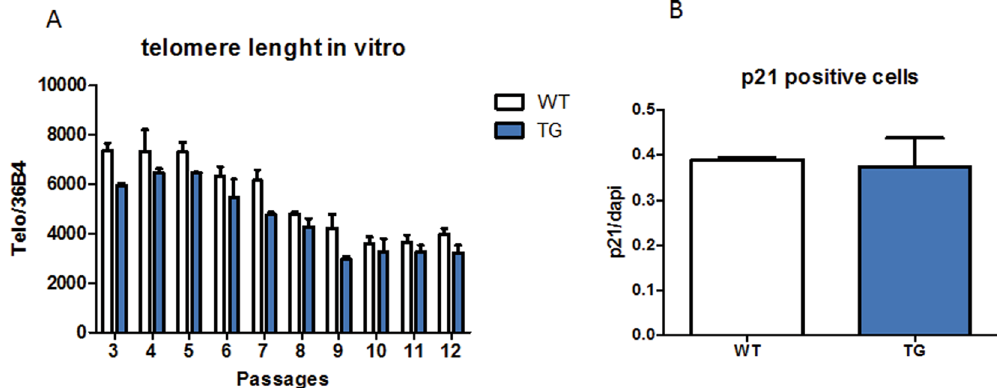
Figure 3. Calpastatin overexpression in tubular cells in vitro does not protect against aging. Prominin 1 positive proximal tubular cells have been isolated by flow cytometry and cultured during 5 months. After 12 passages, telomere lenght decreased similarly in cells from WT and CalpTG (TG) mice ( A , n = 3). In addition, after 6 passages, a similar proportion of WT and CalpTG cells expressed p21, a classical marker of senescence ( B , n =